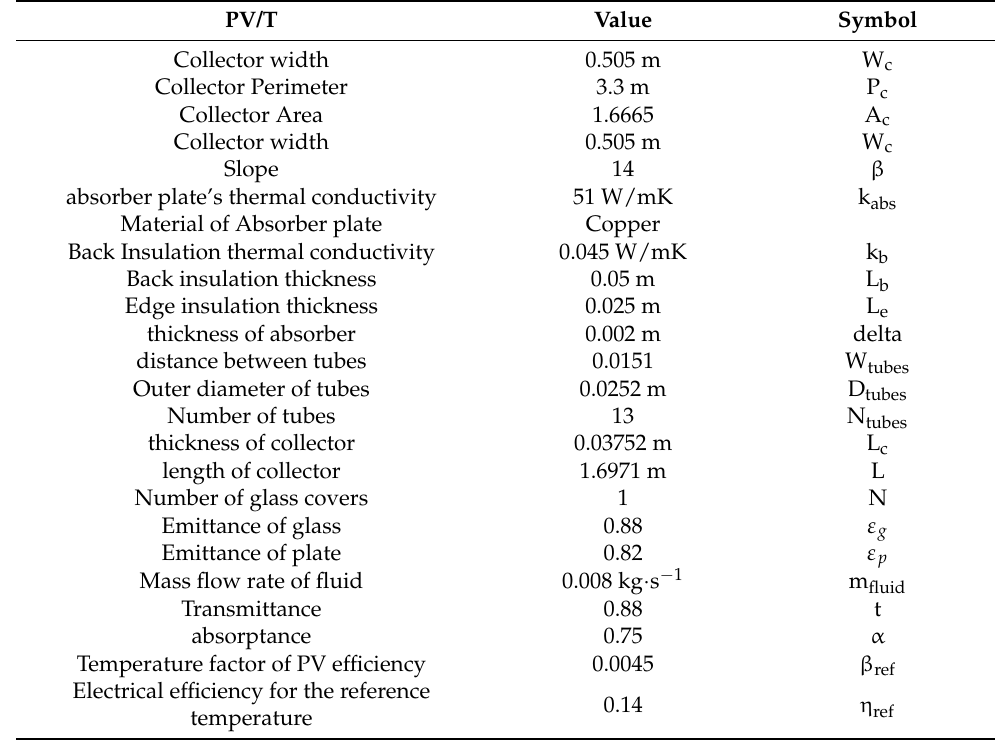
Table 3. PV/T design